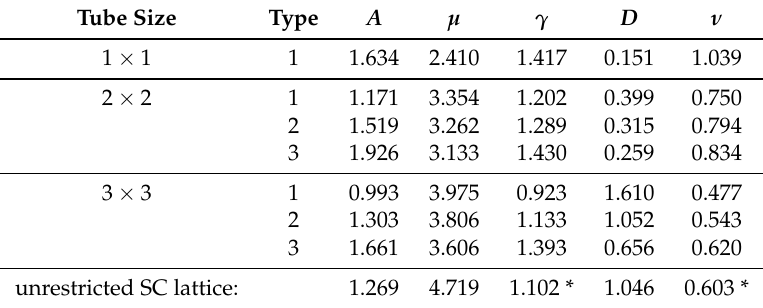
Table 1. Calculated coefficients in scaling laws (Equations (1) and (2)) for SC lattice restricted to a tube oriented along [ 100 ] . Universal exponents for unrestricted SAWs are marked with an asterisk *.